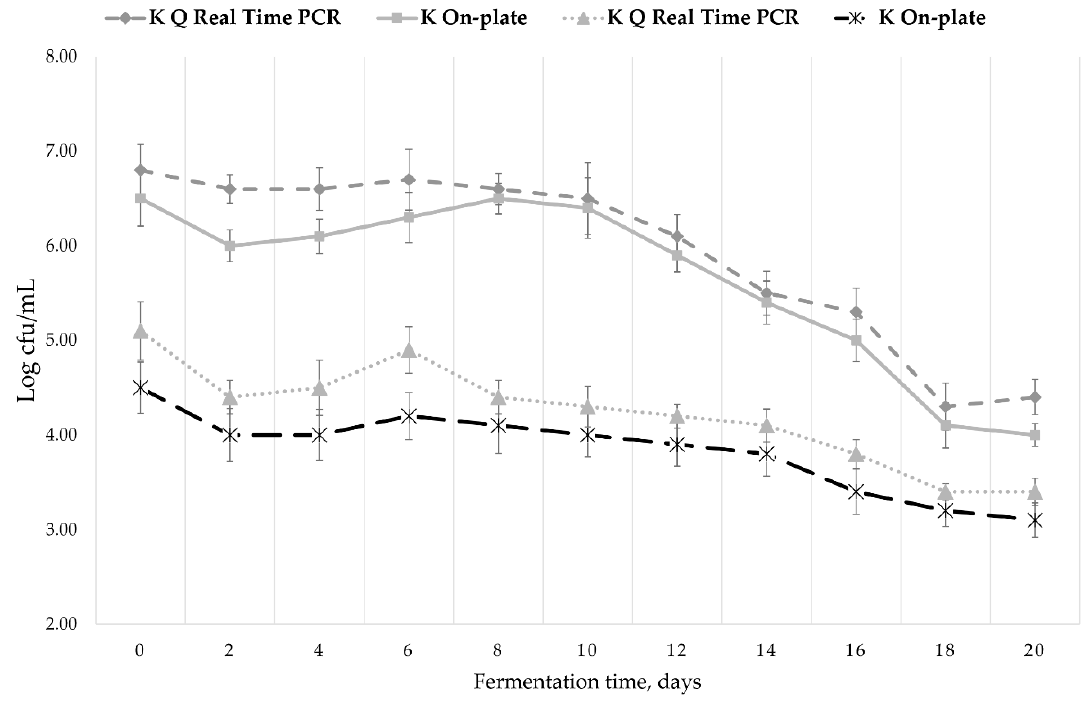
Figure 3. Lactic acid bacteria population during Kombucha without (K) or with pollen (KP) fermentation. Data obtained by q-Real Time PCR versus on-plate quantification.